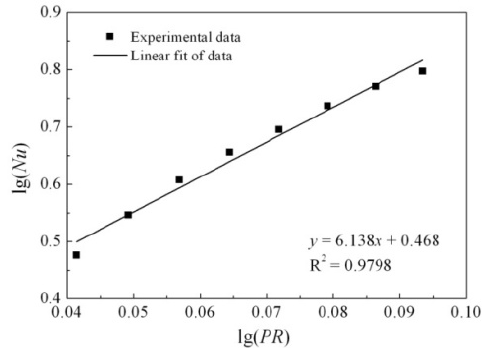
Figure 14. Determination of coefficient b .